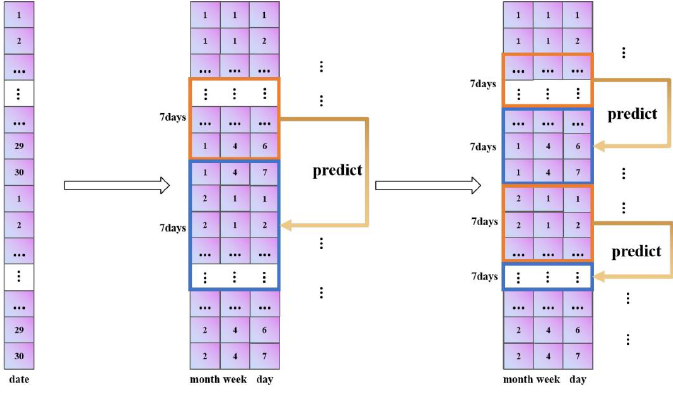
Figure 4. Improvement flow chart.